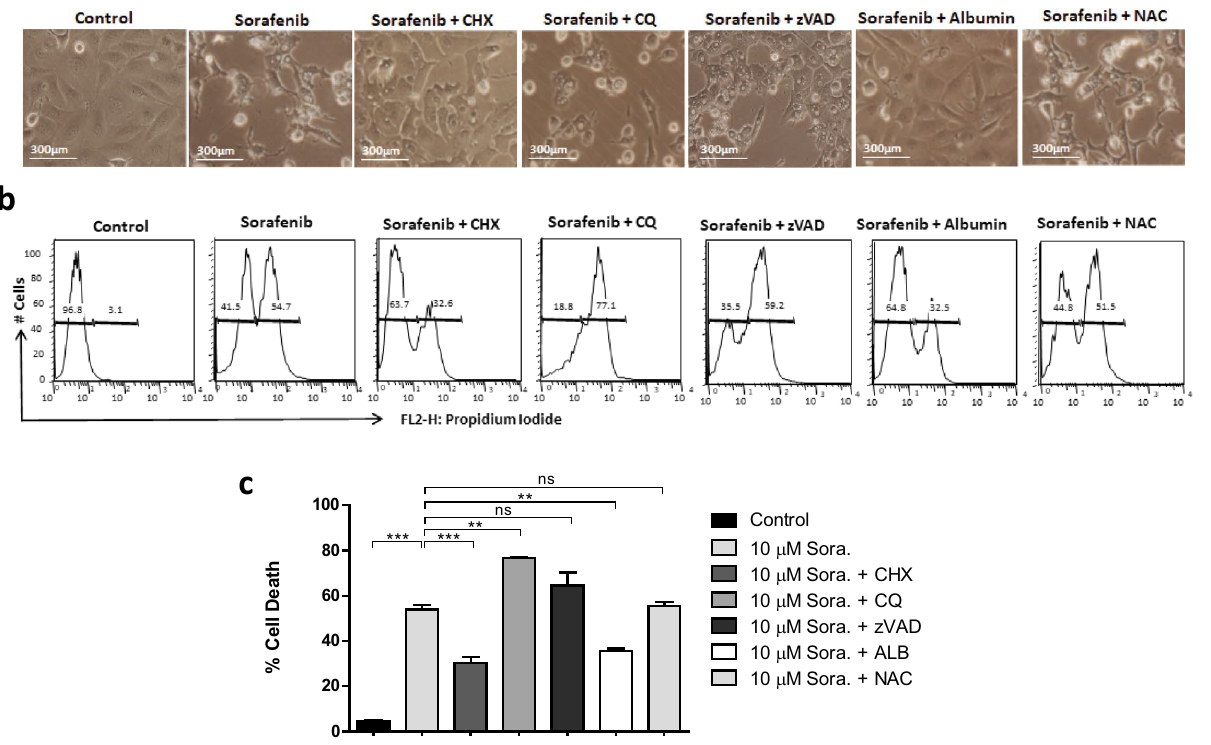
Figure 2. Involvement of non-apoptotic cell death in sorafenib induced LX2 cells depending on dose and time. ( a ) Phase-contrast microscope showing the LX2 cells exposed with 10 µM Sorafenib for 24 h after pre-treatment with protein synthesis inhibitor 25 μM cycloheximide (CHX), autophagy inhibitor, 25 μM chloroquine (CQ), pan-caspase inhibitor, 20 μM Z-VAD-FMK, anti-oxidants 5 μM N -acetylcysteine (NAC) and 5 μM humans serum albumin (ALB). Images were taken using × 20 objective, scale bar: 300 μm. ( b ) 10 µM Sorafenib induced percent cell death and viability of LX2 cells were shown with propidium iodide (PI) positive and negative populations of LX2 cells after pre-treatment with above mentioned inhibitors and anti-oxidants using flow cytometry. ( c ) The quantification of sorafenib induced % cell death of LX2 cells with sorafenib (10 µM) treatment after pre-treatment with above mentioned inhibitors were measured in compare with untreated control. The bars represent mean ± s.d. from three independent experiments (ns > 0.05, *P < 0.05; **P < 0.01; ***P < 0.001 One-way analysis of